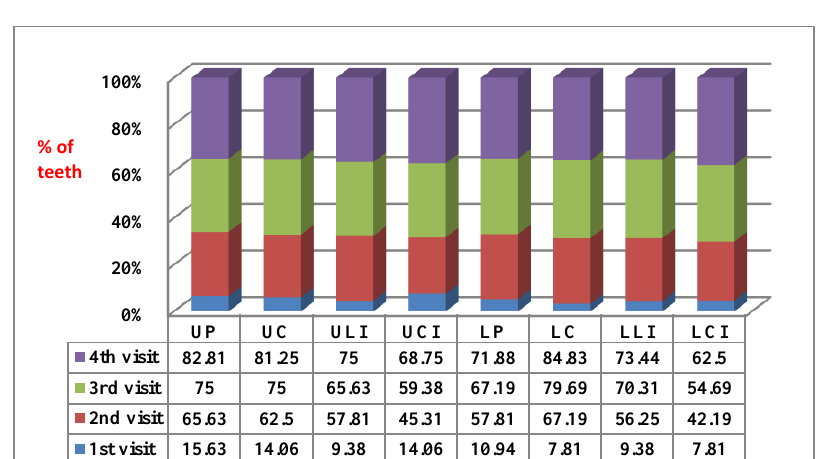
Figure2: The distribution of white spot lesions among teeth in the maxillary and mandibular arches during four time intervals Figure 3 demonstrated the distribution of time intervals. The gingival area was the most white spot lesion around the brackets in affected area in the maxillary and the maxillary and mandibular arches during four